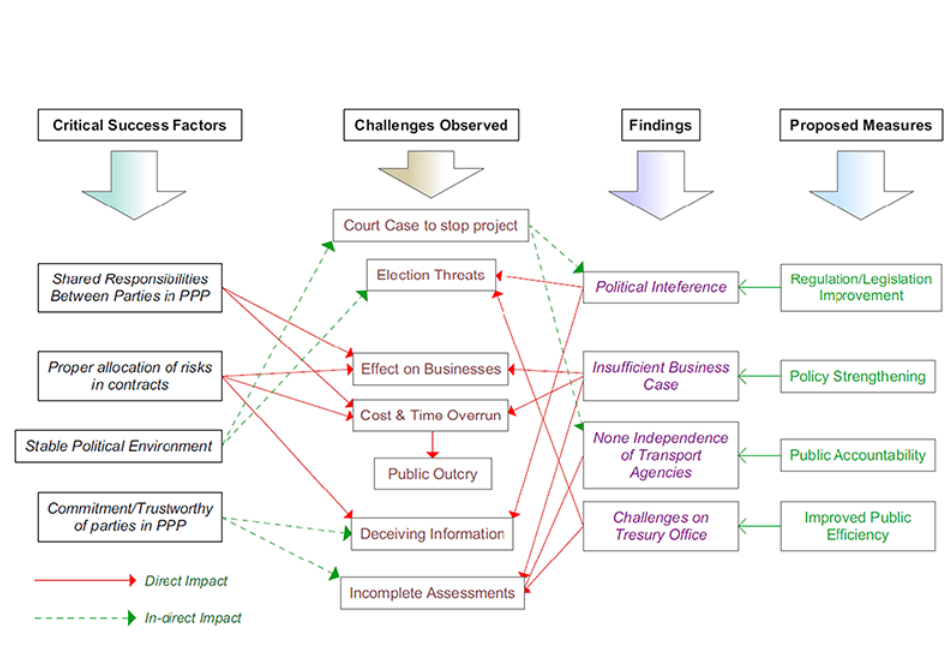
Figure 1 Relationship between critical success factors, challenges observed and mitigation